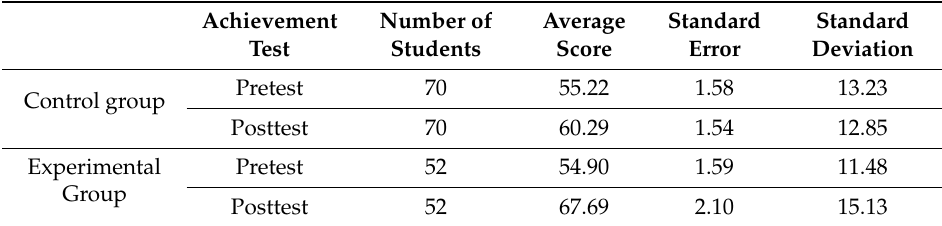
Table 2. Descriptive statistics of achievement test.